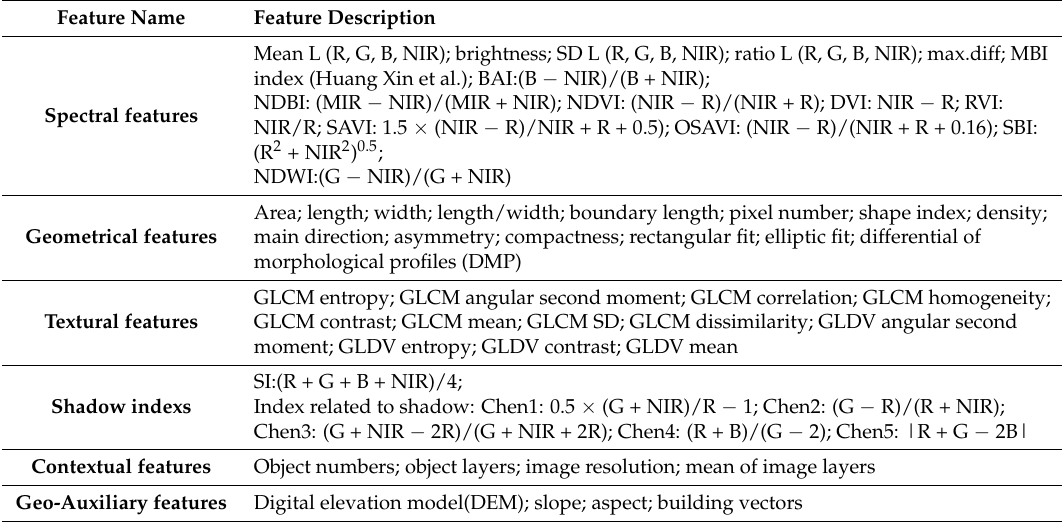
Table 1. Description of features extracted from high resolution remote-sensing images.